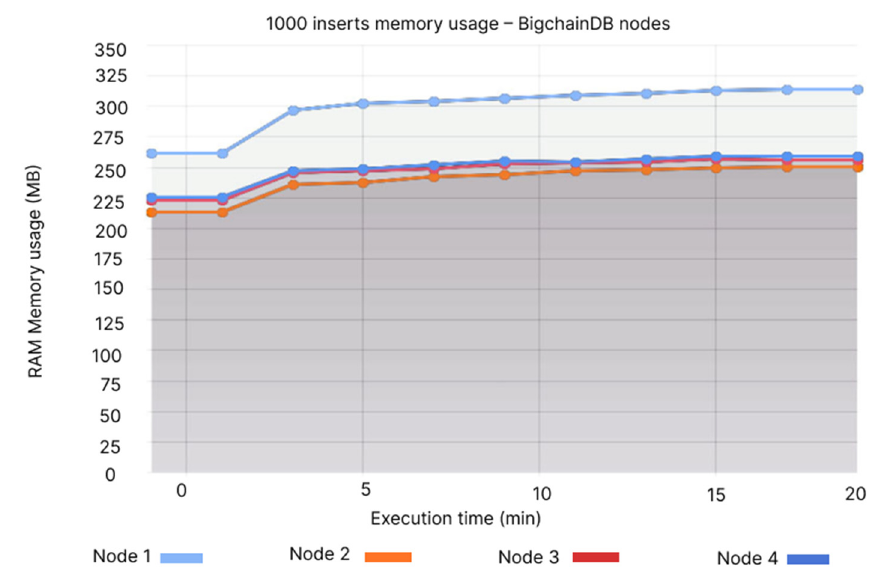
Figure 8. 1000 inserts memory usage—BigchainDB.